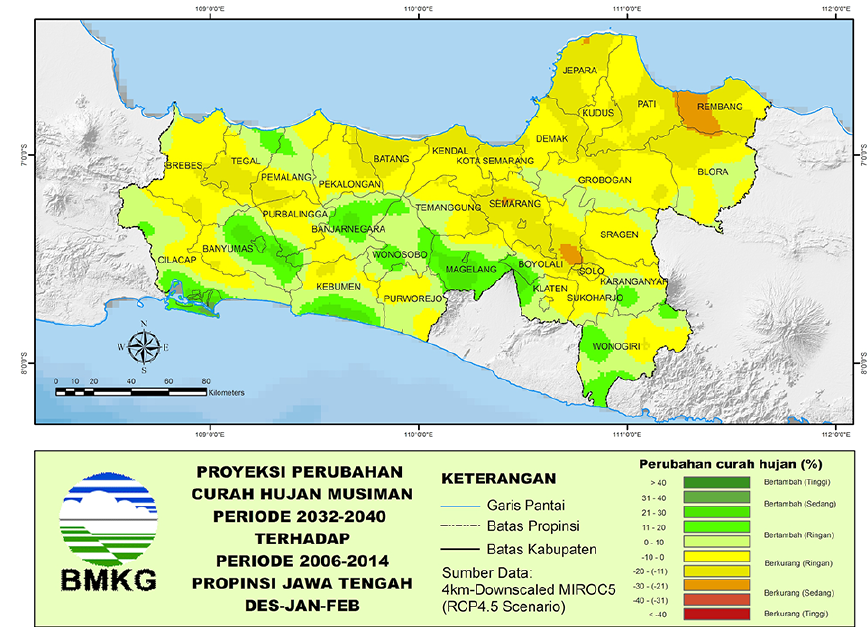
Figure 10. Projected Changes in Rainfall for the Period of 2032 - 2040 (Source BMKG)